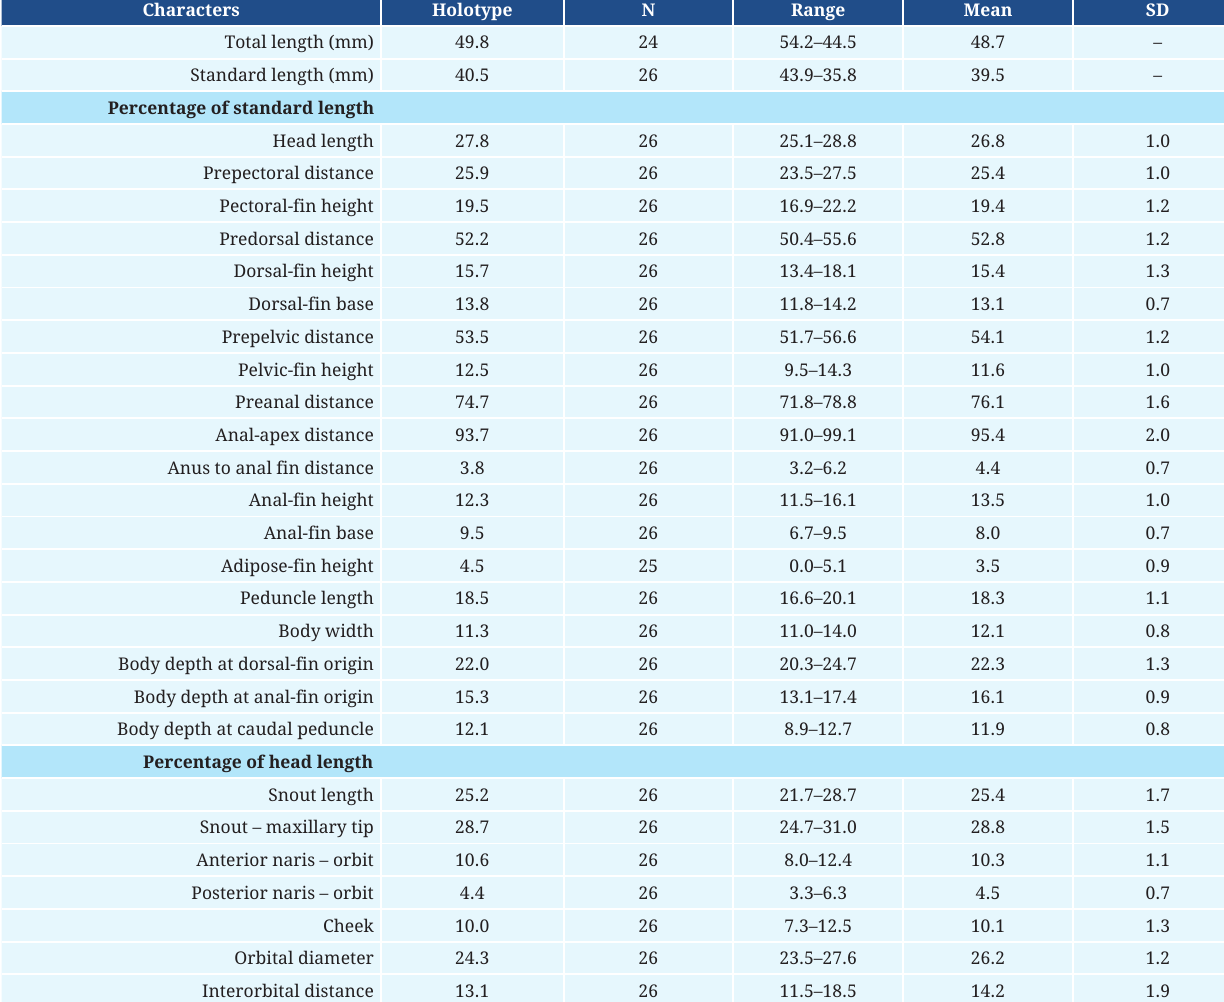
TABLE 1 | Morphometric data for Characidium kalunga . Values for the holotype (MZUSP 125824) and 25 paratypes (MZUSP 114056, 114058). Abbreviations: N, number of specimens; SD, Standard